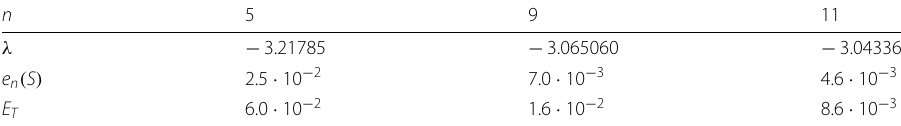
Table 5 Errors e n and E T with the S spline for (21)